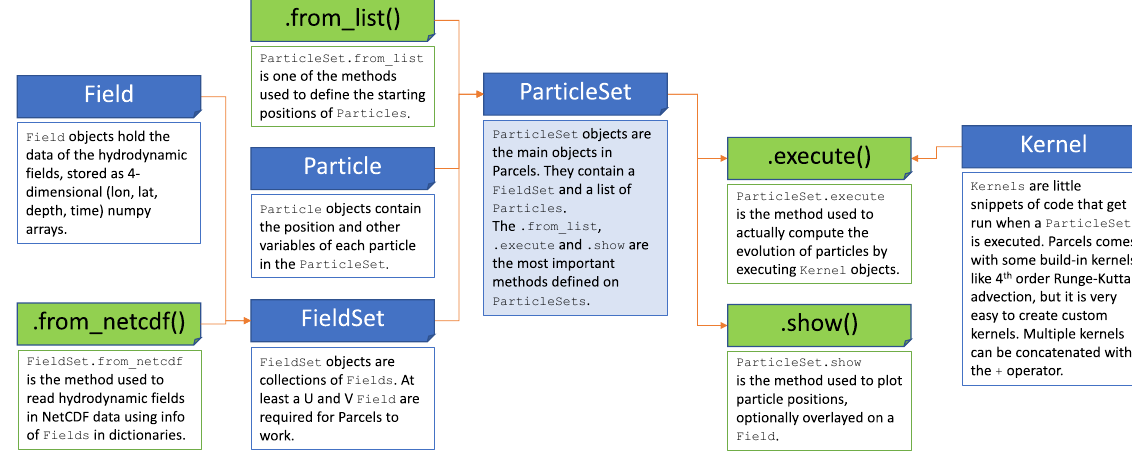
Figure 2. Class diagram of the Parcels v0.9 prototype implementation. Classes are depicted in blue, methods in green. Note that not all methods and classes are shown in this